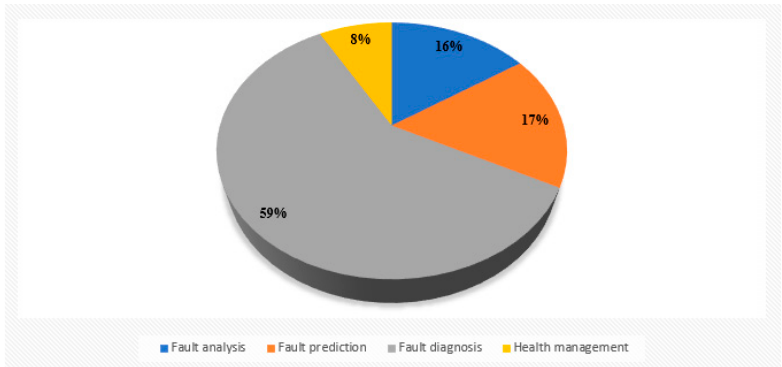
Figure 3. Different research directions of hydraulic pump faults.